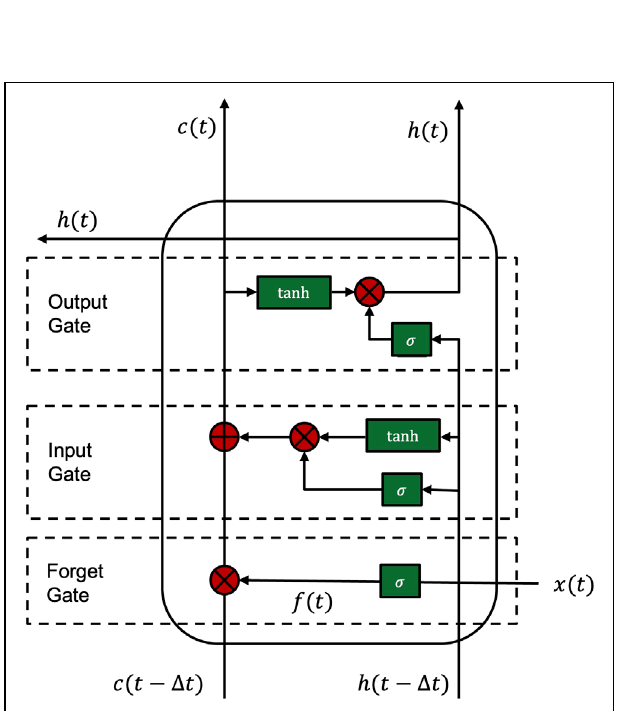
FIGURE 3 | Architecture of LSTM block.